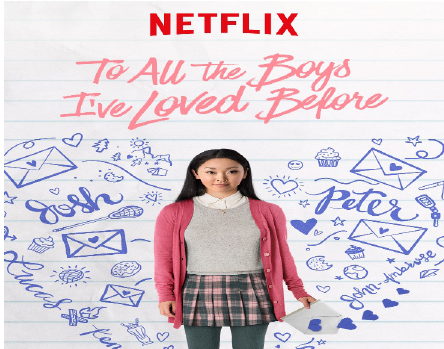
Fig. 4. Baseline model loss and accuracy